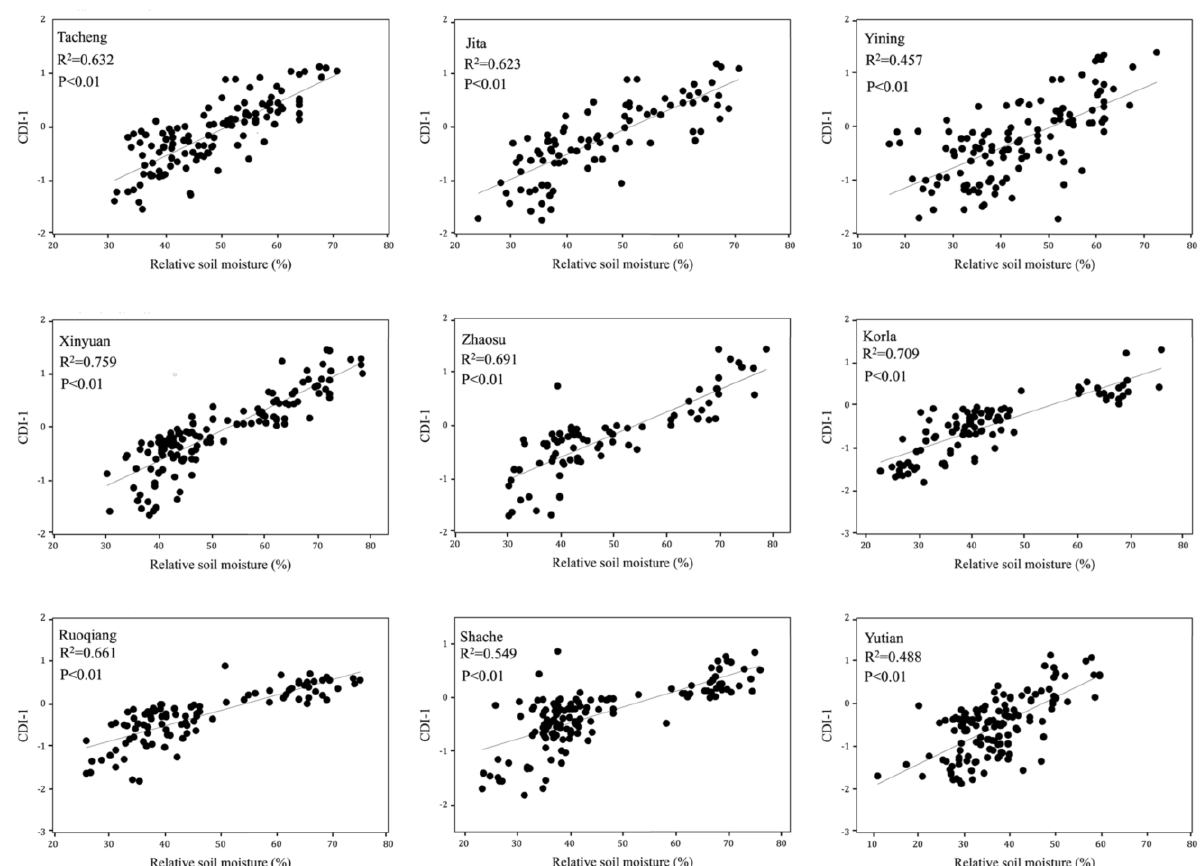
Figure 5. Scatter plot of CDI-1 versus the 10 cm soil relative humidity.